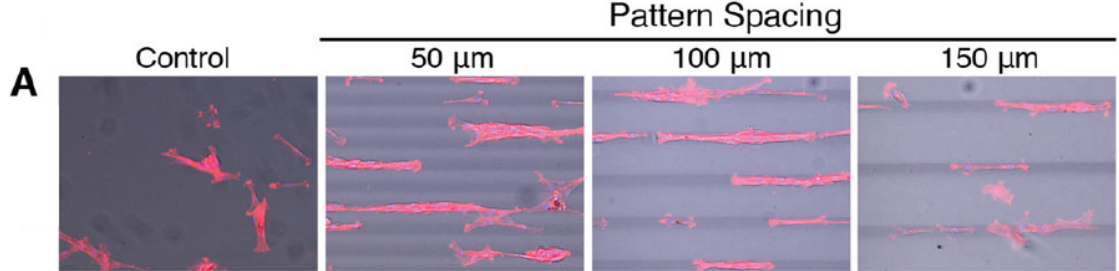
Figure 3. Stiffness-modulated hydrogels with 50, 100, 150 micron spacing between the patterns. A7R5 smooth muscle cells show migration to the stiffer regions patterned by MPL patterning. A7R5 cells stained for actin/nuclei on day 6 after incubation (adapted and printed with permission from [87]).